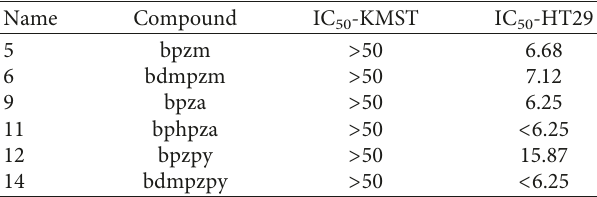
Table 1: The experimental anticancer activities of selected